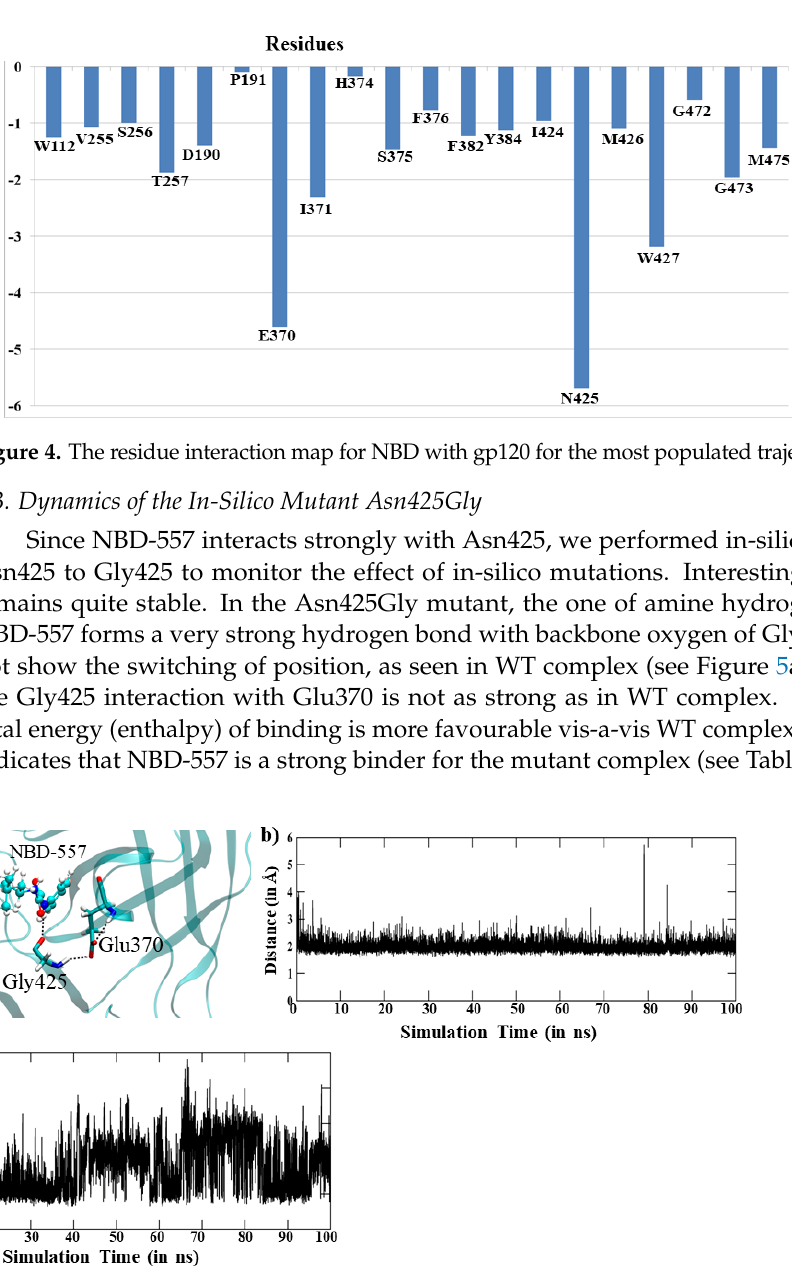
Figure 5. Results from the MD of N239G mutant. ( a ) NBD-557 binding in the gp120 binding pocket. ( b ) The distance vs . simulation time for the H-bond between amine hydrogen of NBD-557 and backbone oxygen of Gly425. ( c ) Distance vs. time for the H-bond between Gly425 and Glu370. Note that all results are reported for the most populated trajectories of 100 ns.